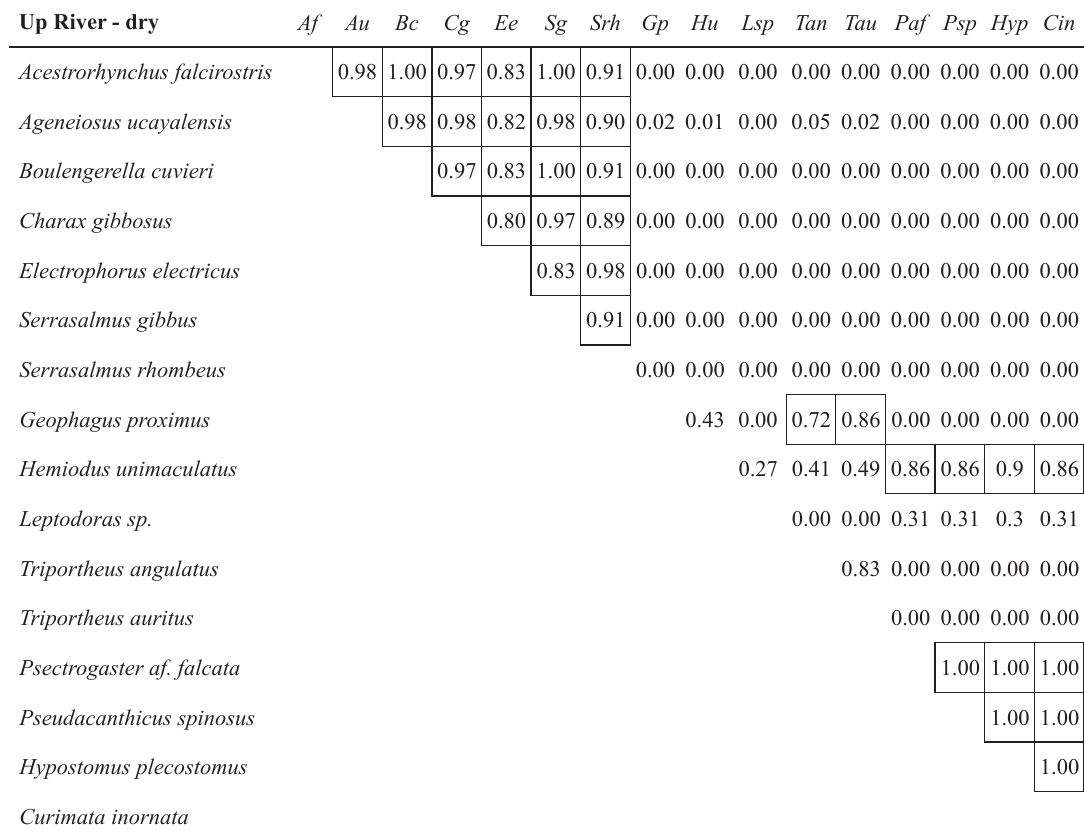
Niche overlap between pairs of species analyzed from Upriver area of Coaracy Nunes Dam, Ferreira Gomes – Amapá (AM-Brazil).